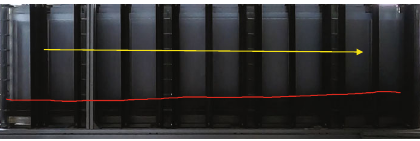
Figure 16: 40/70 mesh ceramic sand embankment con fi guration with sand-carrying liquid viscosity of 24mPa s.